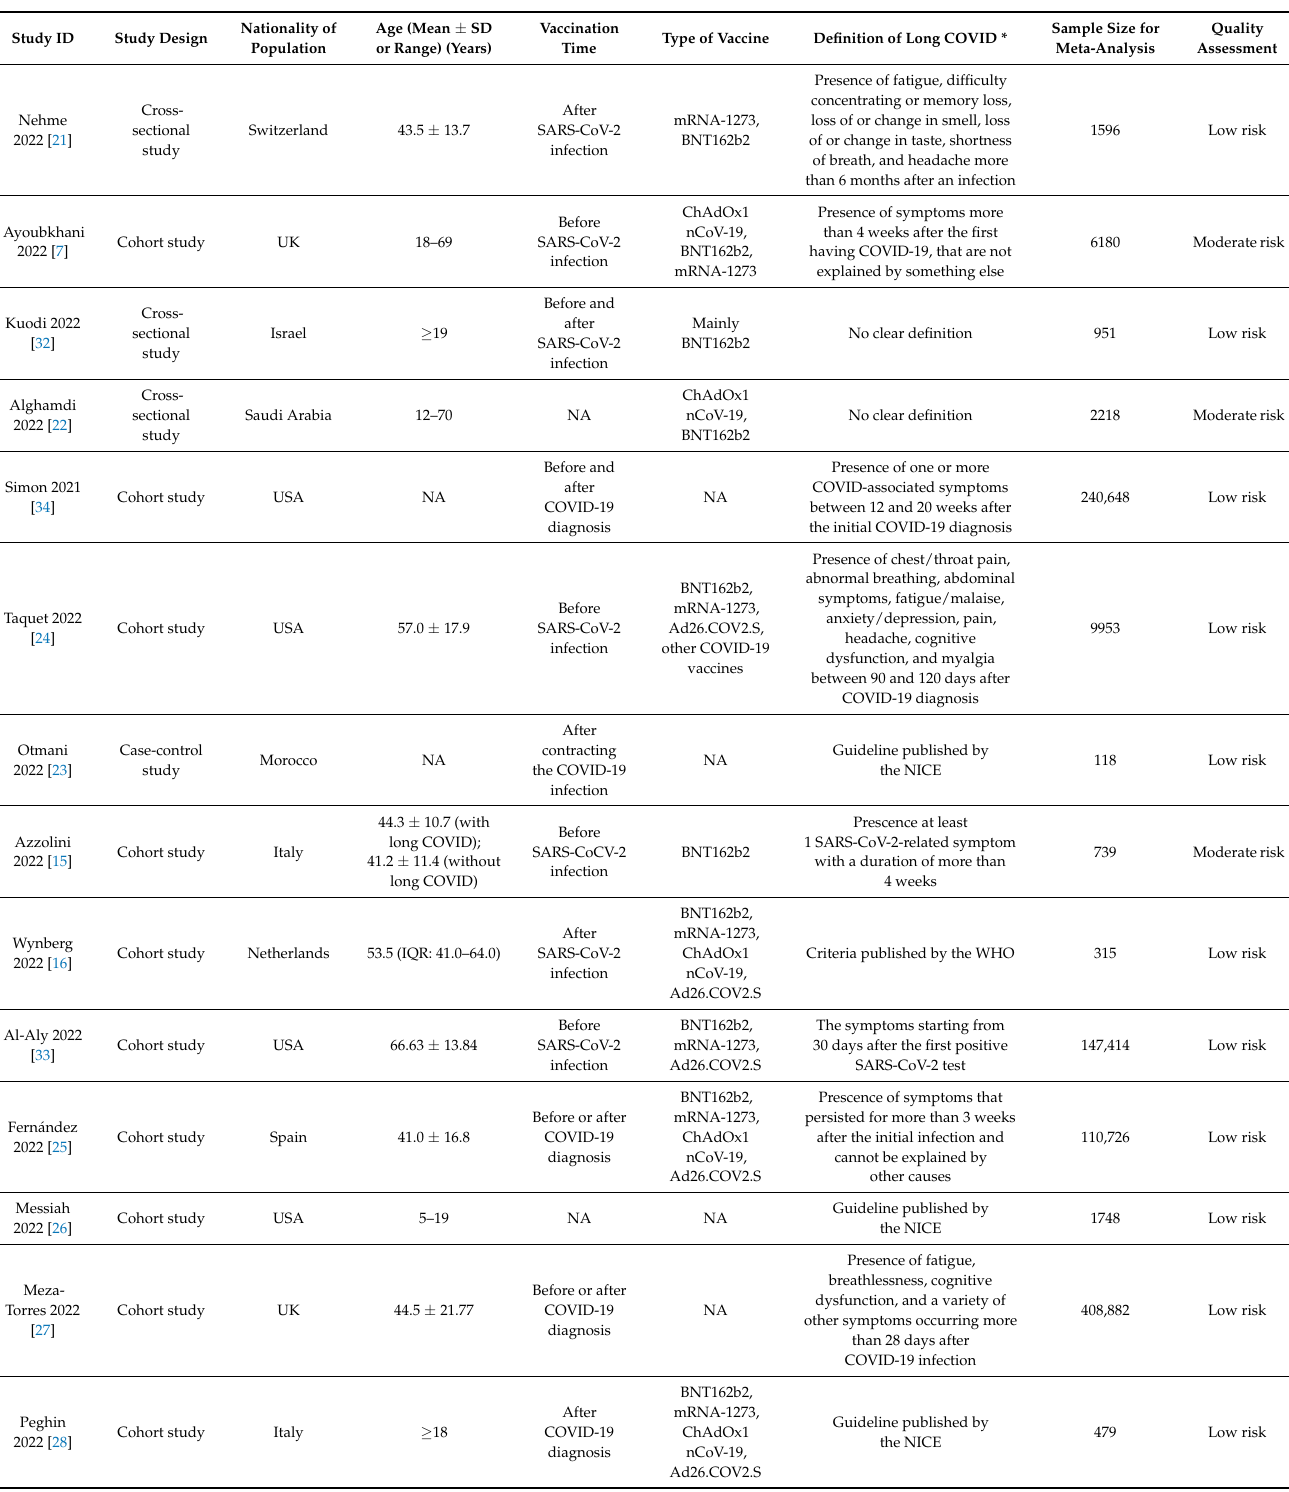
in Figure 3. The result of the Egger test (t = − 0.46, df = 13, p -value = 0.65) suggested no publication bias in the primary meta-analysis. Table 1. Characteristics of the included